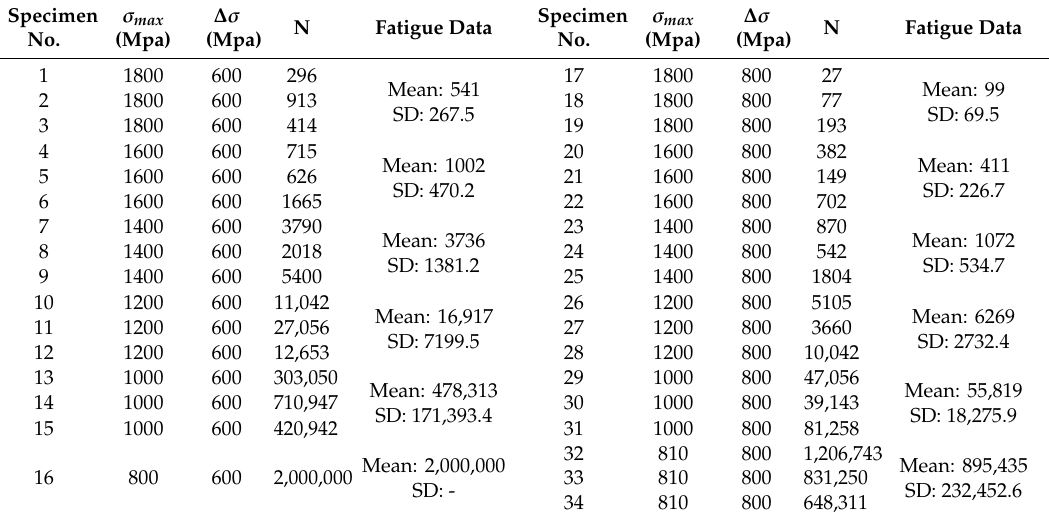
Figure 6. Fatigue failure of tendons. Table 2. Test